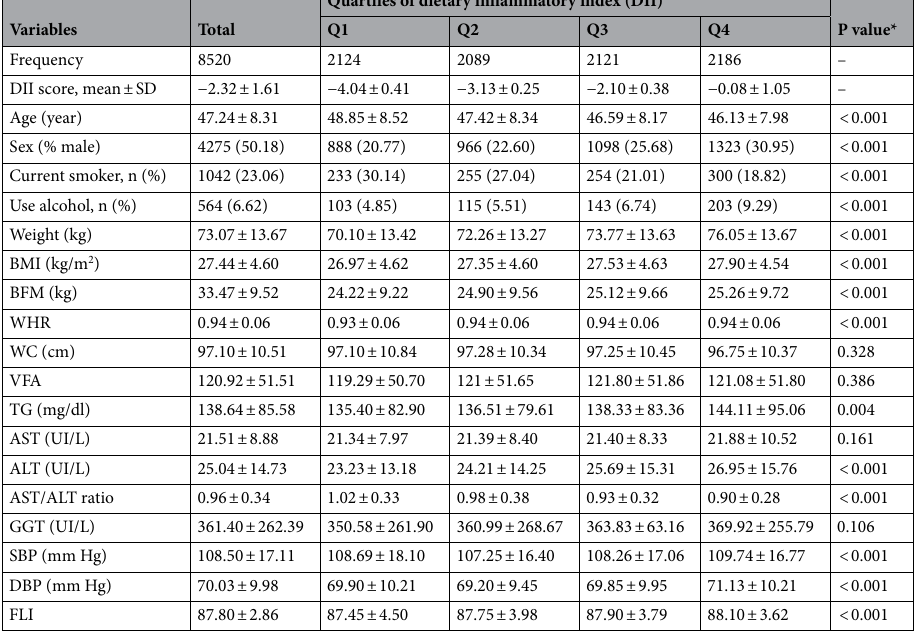
Table 1. Baseline characteristics, anthropometric and biochemical of participant’s factors according to the dietary inflammatory index score. AST aspartate transaminase, ALT alanine aminotransferase, BFM body